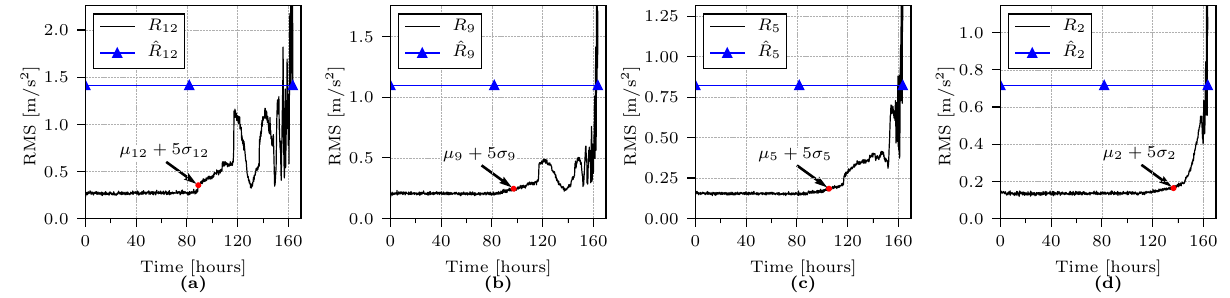
[4400, 4800] Hz; (b) R 12